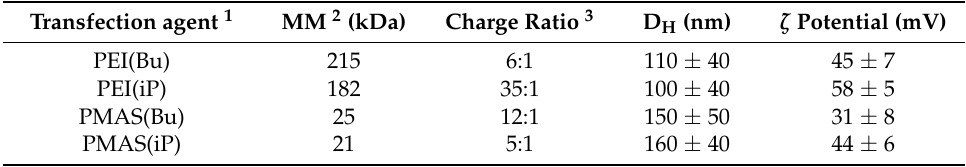
Table 1. Characterization of transfection agents and polyplexes at optimal transfection efficacy. Transfection agent